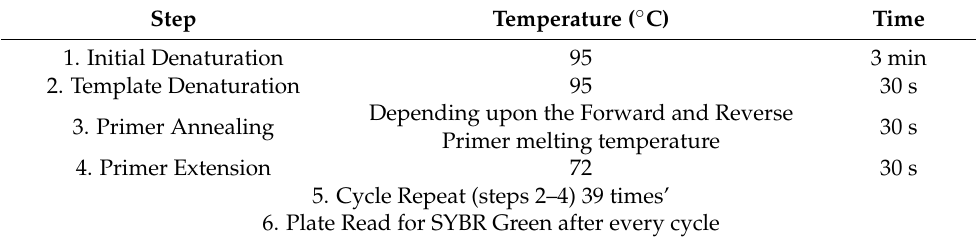
Table 3. Experimental protocol used for qRT-PCR